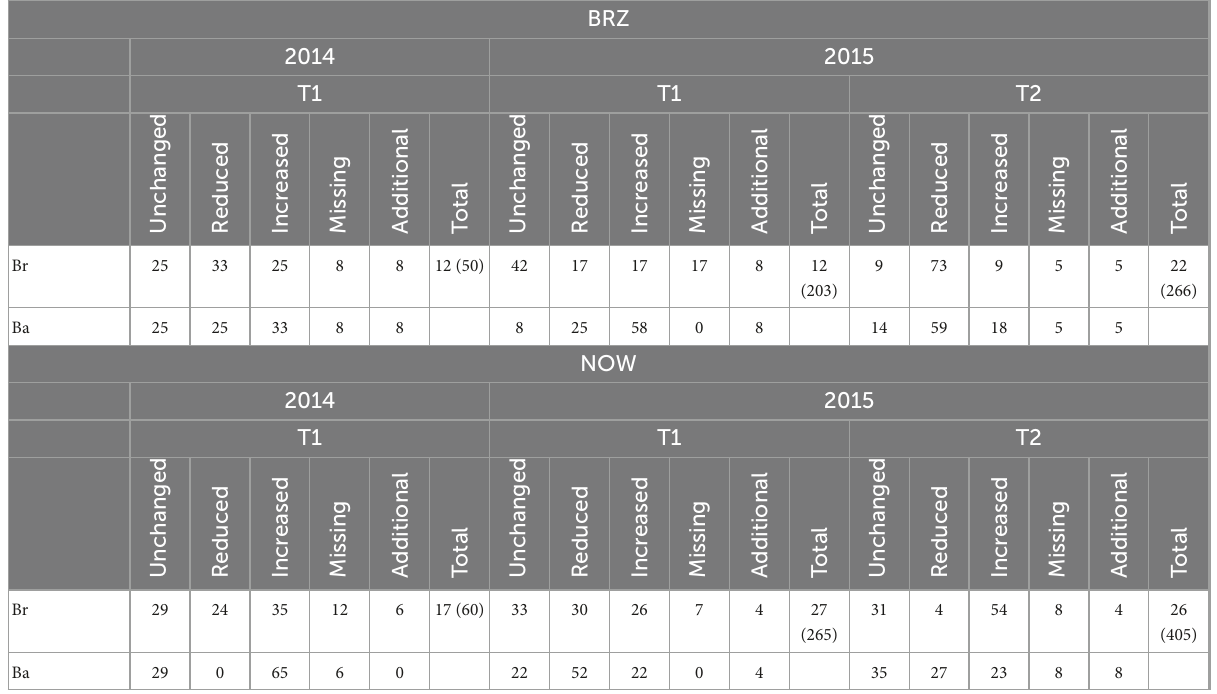
TABLE 2 Percentage of fungal operational taxonomic units (OTUs) categorized according to the comparison of intensity with the